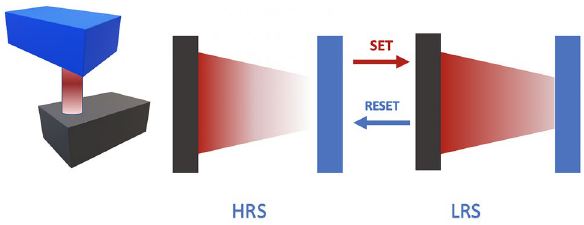
Figure 1. Memristor